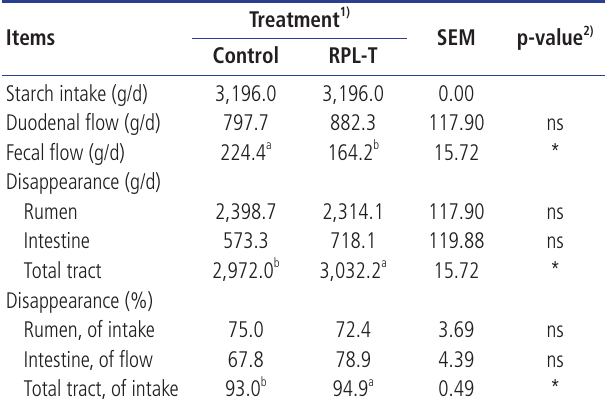
Table 3. Apparent starch loss in each segment of the gastrointestinal tract in Korean native steers fed basal diet and RPL-T